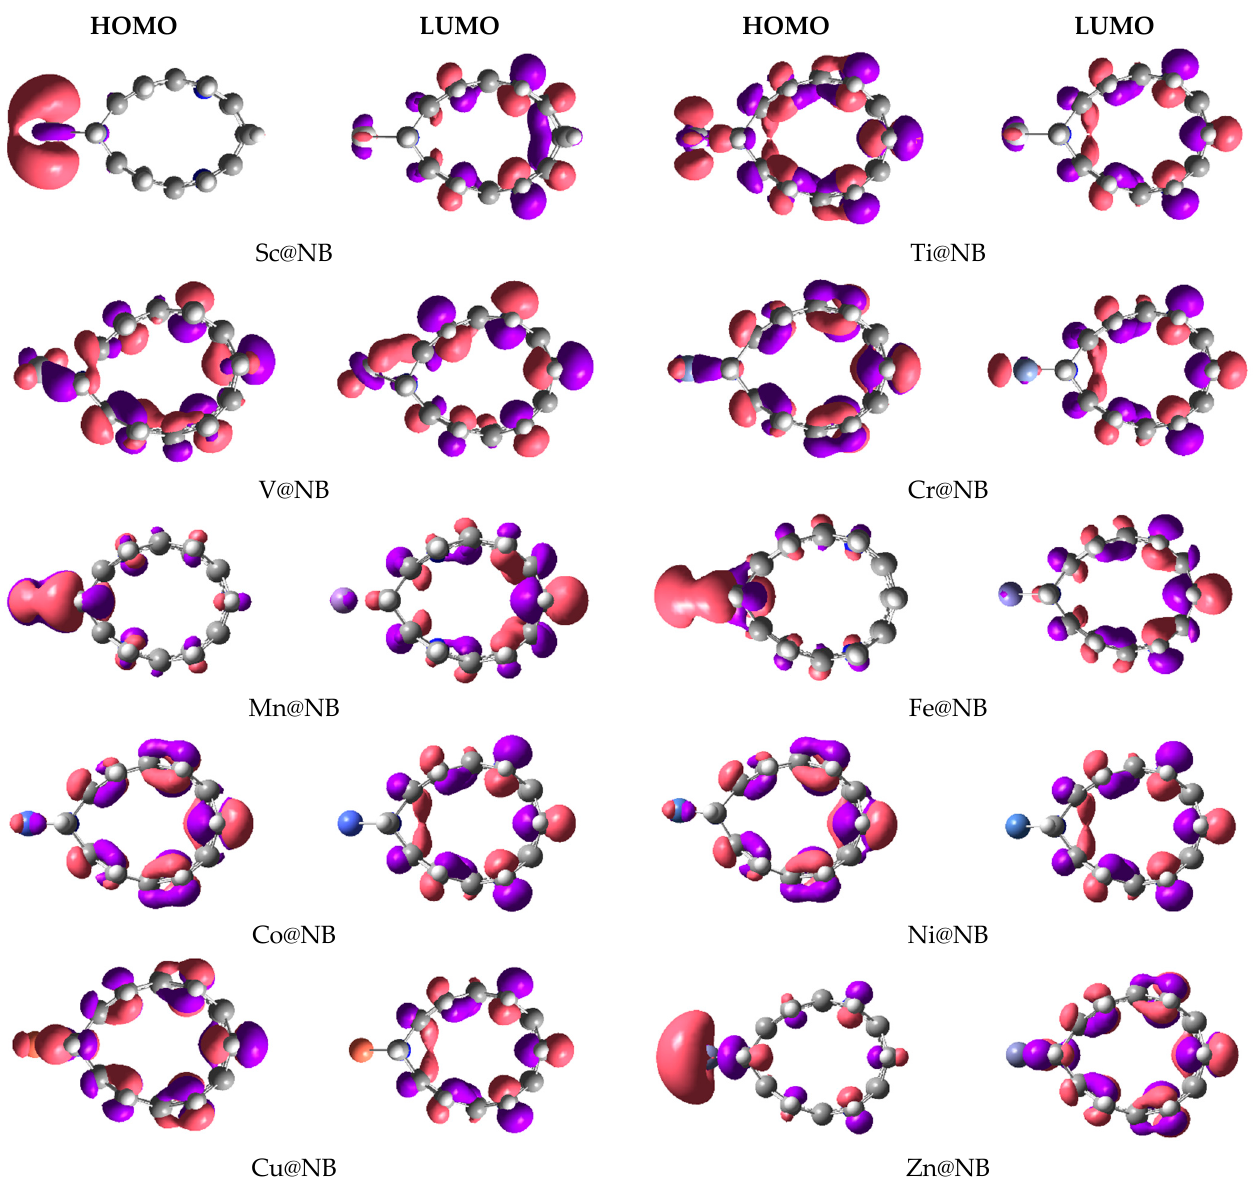
Figure 3. HOMO-LUMO orbital density distribution of studied TM@NB complexes (TM =